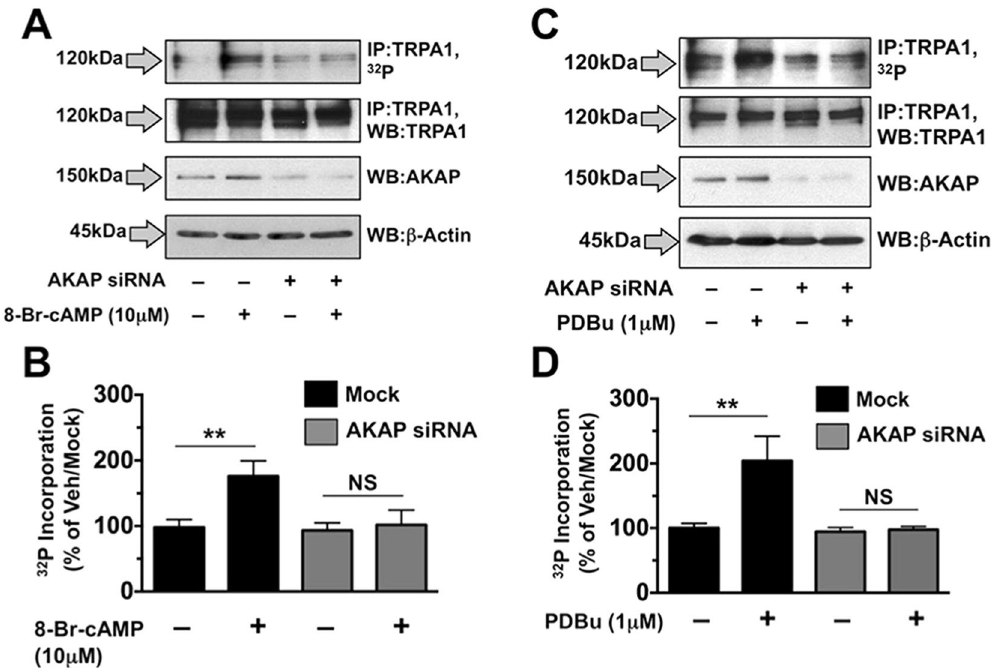
Figure 4. TRPA1 Phosphorylation by PKA and PKC is Dependent on AKAP Expression. Cultured rat trigeminal neurons were grown on 10-cm plates, and transfected with siRNA directed against AKAP, as illustrated. Cultures were then incubated with 32 P-orthophosphate for 4 h, prior to treatment with vehicle 8-Br- cAMP (10 μ M, A , B ), or vehicle vs. phorbol 12,13-dibutyrate (PDBu, 1 μ M, ( C , D ) for 5 min before harvesting and immunoprecipitation (IP) of TRPA1. Immunoprecipitants and aliquots of general lysates were resolved by SDS-PAGE and Western blot (WB), as depicted. Representative autoradiographic and WB results are shown ( A and C ). Quantified autoradiographic results were normalized to total TRPA1 IP ( B and D ). Results are representative of 4–5 independent trials; ** p < 0.05; ns = no significance; two-way ANOVA with Bonferroni post-hoc